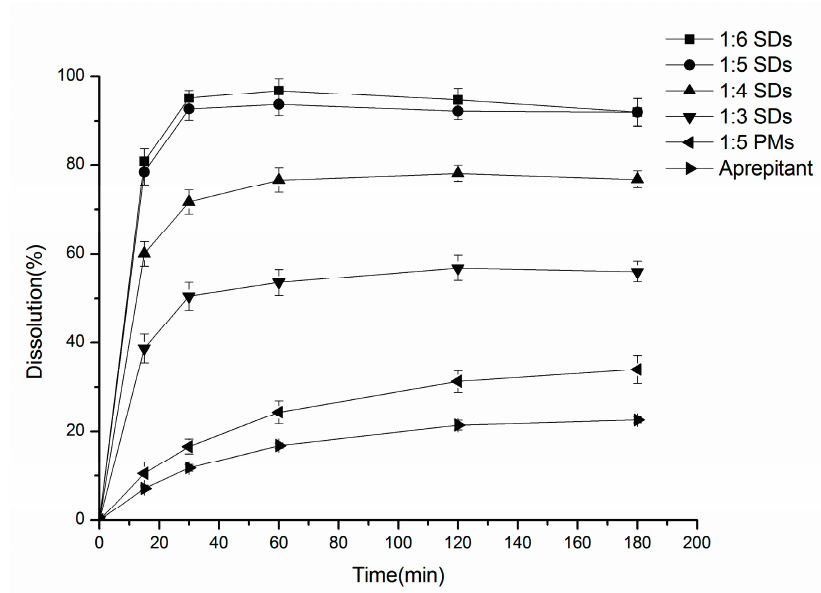
Figure 1. Dissolution profile of aprepitant and solid dispersions at different aprepitant/Soluplus ® ratios of 1:6, 1:5, 1:4, 1:3 and PMs. Each point represents the mean ± SD ( n =